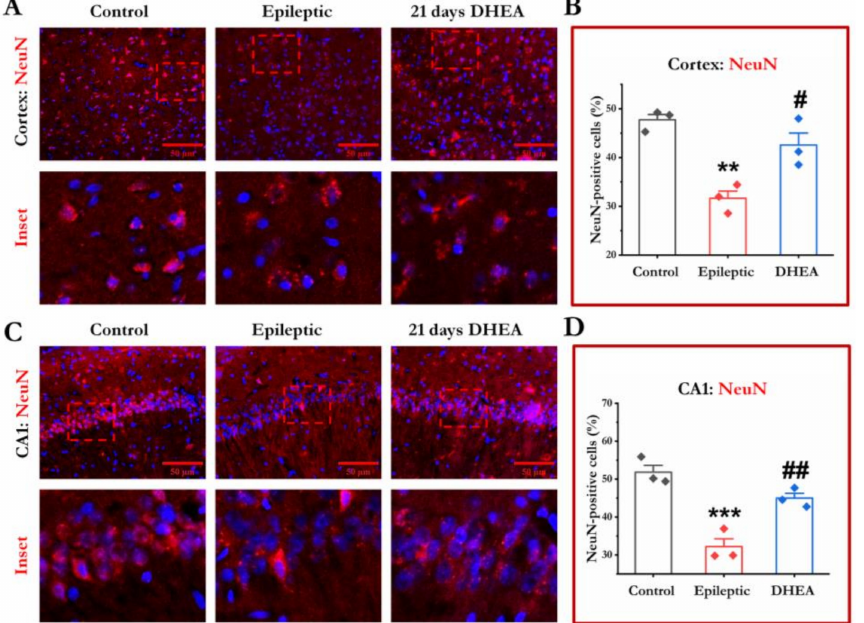
Figure 4. Immunofluorescence analysis of neuronal loss in the cortex and hippocampus regions of control, epileptic and DHEA-treated rats. Representative photomicrographs showing NeuN- positive cells (red) ( A , C ). Percentage of NeuN-positive cells in the cortex ( B ) and hippocampus ( D ) of experimental rats. Data are expressed as mean ± SD (n = 3 in each group). ** p ≤ 0.01, *** p ≤ 0.001 significantly different from control group; # p ≤ 0.05, ## p ≤ 0.01 significantly different from epileptic group. ANOVA F values for percentage of NeuN-positive cells: cortex 16.623; hippocampus